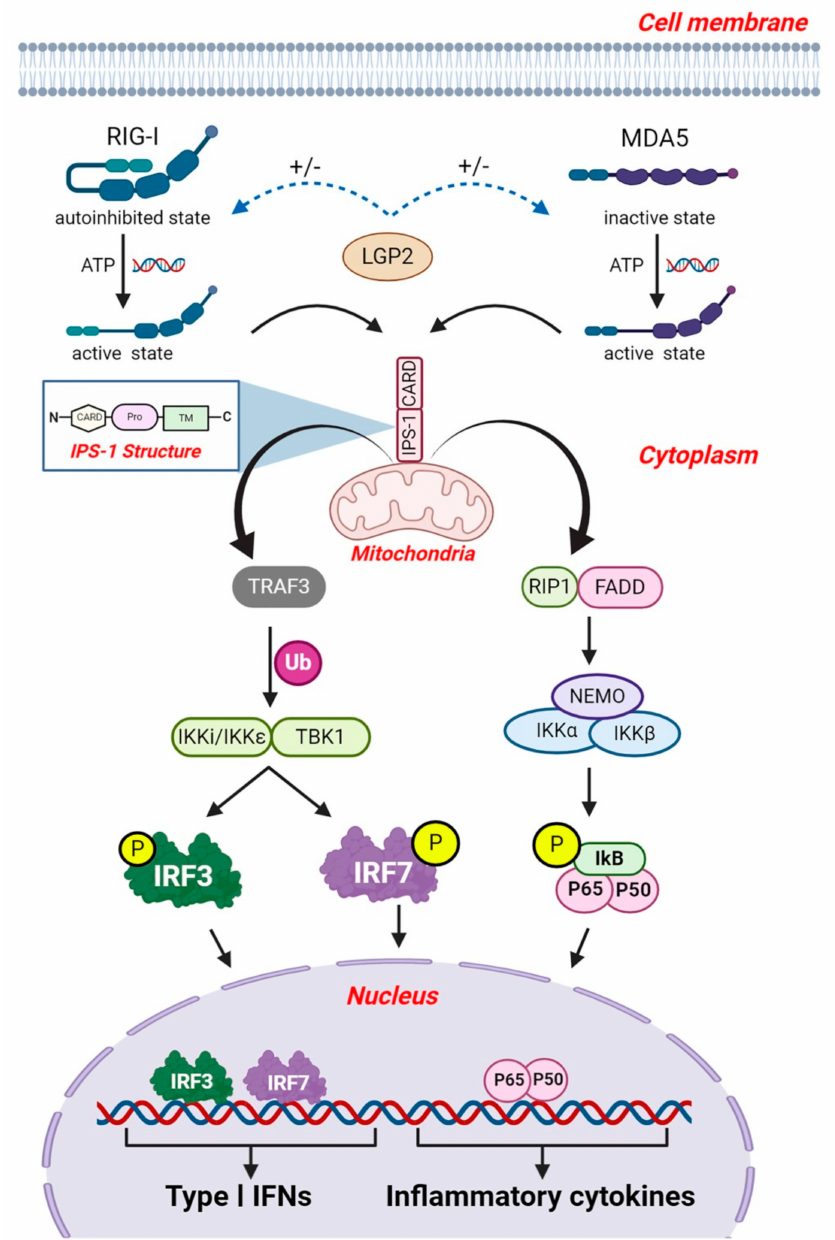
Figure 4. RLR signaling pathway. During viral infection, PAMPs in the cytoplasm are recognized by RIG-I and MDA5 leading to their activation. RIG-I and MDA5 interact with IPS-1 adaptor protein located on the mitochondria via its CARD domain. This interaction results in downstream activation of TRAF3, followed by the K63 polyubiquitination (Ub) of TBK1 and IKK i /IKK ε , which phosphorylates IRF3 and IRF7, leading to the production of type I IFNs. IPS-1 also activates NF- κ B via FADD and RIP1 dependent pathways. FADD and RIP1 form a complex followed by the recruitment of IKK α and IKK β . This transcription factor complex mediates the translocation of NF- κ B (p65/p50) into the nucleus, which initiates the production of inflammatory cytokine. ‘P’ indicates phosphorylation. LGP2 is essential to produce antiviral responses but lacks a CARD domain and thus fails to autonomously transduce signaling [202]. Structural and functional studies show that LGP2 promotes the nucleation of MDA5 oligomerization on dsRNA and signaling [135]. LGP2 also potentially co-cooperates with other PRRs to regulate IFN signaling. LGP2 was originally suggested to be a negative inhibitor of RIG-I and MDA5 [167]. However, recent studies showed LGP2 positively regulates the RLR signaling particularly